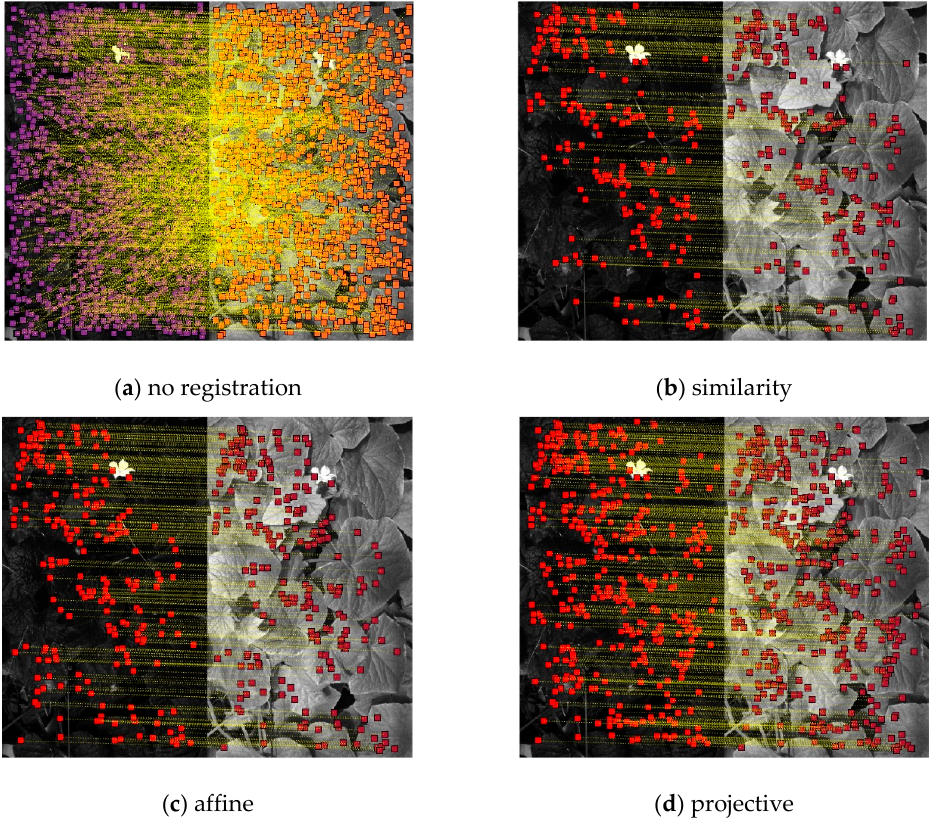
Figure 9. Comparison between the distribution of the total number of matching points and the inliers matching points for the MicaSense ® RedEdge red and red-edge band images in the case of the following geometric transformations: no registration ( a ), similarity ( b ), affine ( c ), and projective ( d ). Outliers matching points were detected using the M-estimator Sample Consensus (MSAC) algorithm.